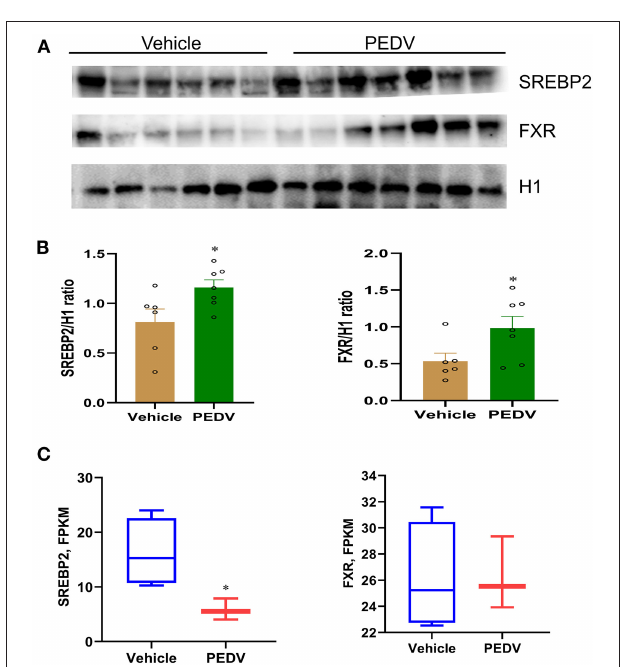
FIGURE 6 | The nuclear expression of SREBP2 and FXR was upregulated in the livers of PEDV-infected piglets. (A,B) Western blotting analysis was performed to evaluate the expression of nuclear SREBP2 and FXR at the protein level. Based on the intensity of protein bands, the expression of SREBP2 and FXR were normalized to that of histone H1, n = 6–7. (C) Graphic summary of mRNA expression of sterol regulatory element-binding protein 2 (SREBP2) and farnesoid X receptor (FXR) by RNA-seq analysis, n = 3–4. The data are shown as the means ± SEM, * P < 0.05, using the two-tailed Student t